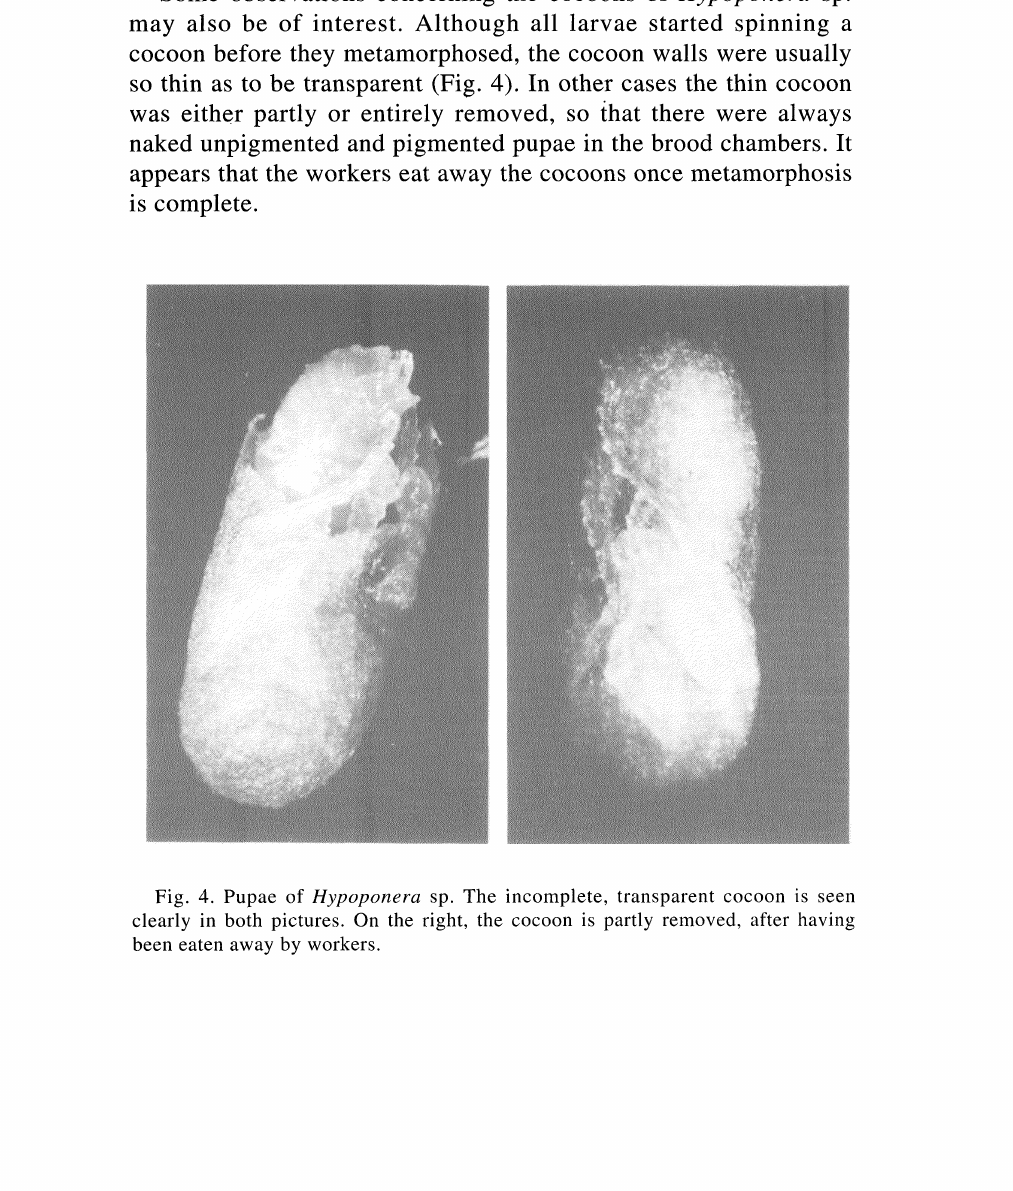
Fig. 4. Pupae of Hypoponera sp. The incomplete, transparent cocoon is seen clearly in both pictures. On the right, the cocoon is partly removed, after having been eaten away by